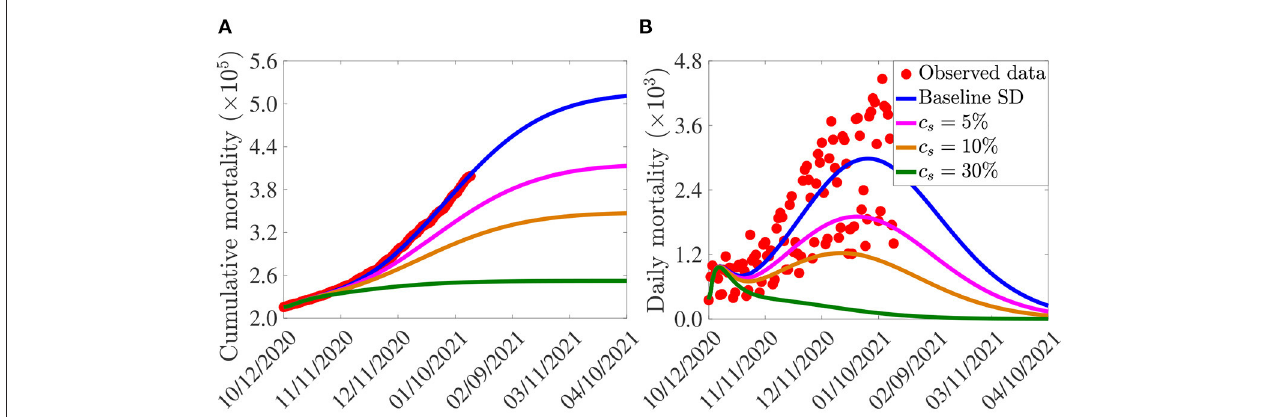
FIGURE 5 | Assessment of the singular impact of increases in baseline social-distancing compliance on COVID-19 pandemic in the U.S. Simulations of the model (2.5)–(2.6) showing (A) cumulative mortality, as a function of time; (B) daily mortality, as a function of time, for various levels of increases in baseline social-distancing (SD) compliance ( c s ) attained during the third wave of the pandemic in the United States. Parameter values used in the simulations are as given by the baseline values in Tables 3 , 4 , with β 1 and β 2 multiplied by (1 − c s ).